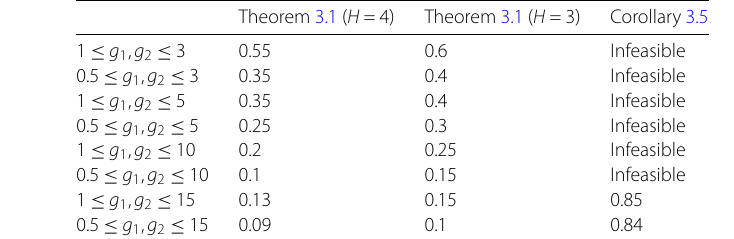
Table 1 The minimum admissible value of control width under period T = 2